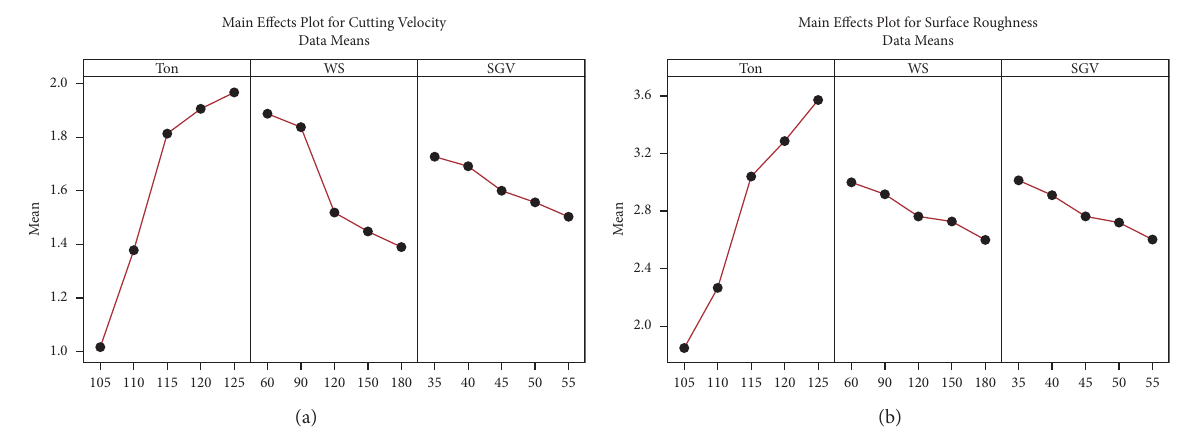
Figure 3: Variation of (a) cutting velocity and (b) surface